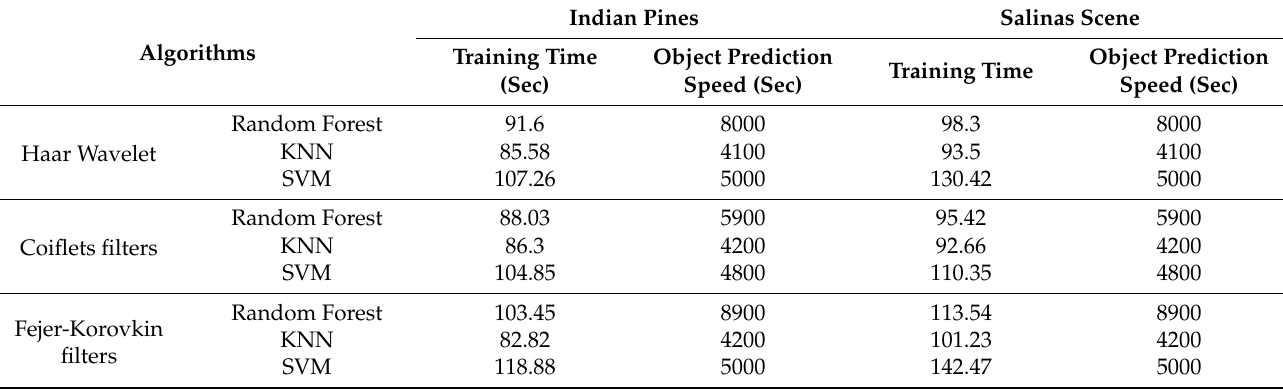
Table 7. Computation time of training phase and prediction speed of testing data.